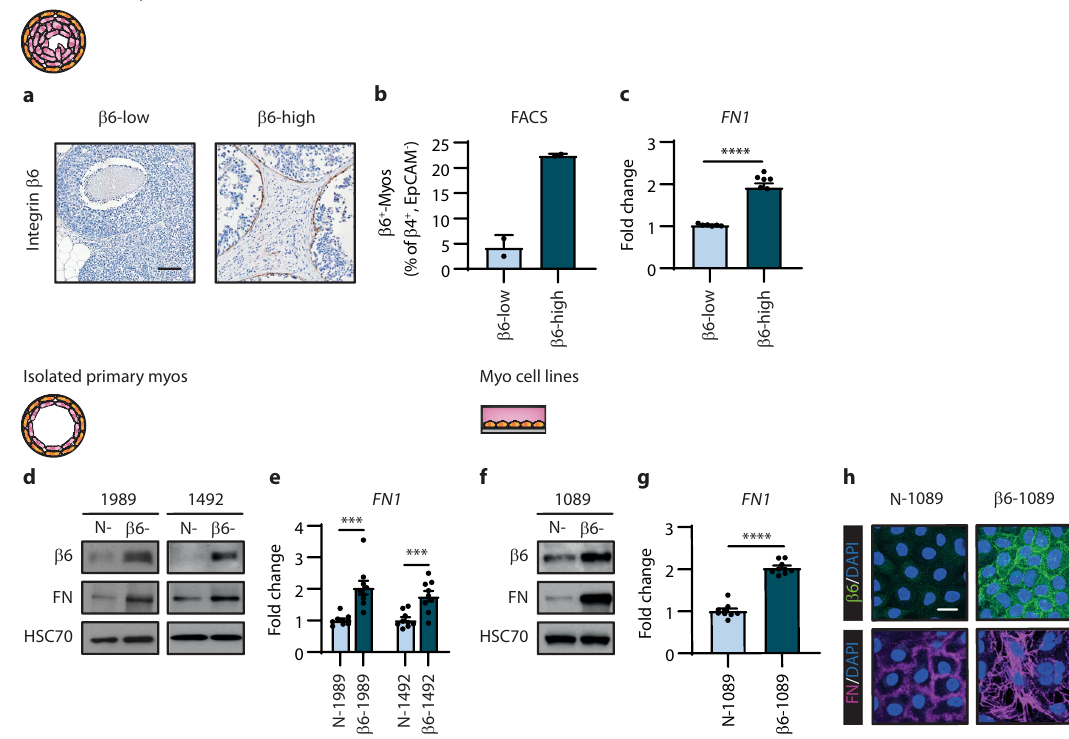
Fig. 2 Integrin β 6-positive myoepithelial cells upregulate fi bronectin expression. a Representative images of integrin β 6 by immunohistochemical staining in human DCIS tissue samples classi fi ed as low and high expression of integrin β 6. Scale bar, 100 μ m. b Bar graph showing the percent integrin β 6-positive ( β 6 + ) myoepithelial (myo) cells ( β 4 + EpCAM - ) in human DCIS samples ( n = 4) (error bars, + s.e.m). c Bar graphs showing qRT-PCR analysis for FN1 using RNA isolated from DCIS myoepithelial cells with integrin β 6-low ( n = 2) and β 6- high ( n = 2) expression (error bars, + s.e.m). 3 technical replicates; **** P < 0.0001 (two-tailed t -test). d Immunoblots of integrin β 6 and fi bronectin (FN) in primary normal myoepithelial cells; 1989 and 1492, transfected with an empty vector (N-) or integrin β 6 expression construct ( β 6-). HSC70 serves as loading control. Images are representative of three experiments. e Bar graphs showing qRT-PCR analysis for FN1 using RNA isolated from primary normal myoepithelial cells, generated as in ( d ) (error bars, + s.e.m). n = 3 biological replicates, 3 technical replicates; 1989 *** P = 0.0003 and *** P = 0.0009 (two-tailed t -test). f Immunoblots of integrin β 6 and fi bronectin in myoepithelial cell lines; N-1089 and β 6-1089. HSC70 serves as loading control. Images are representative of three experiments. g Bar graphs showing qRT-PCR analysis for FN1 using RNA isolated from myoepithelial cell lines as in ( f ). n = 3 biological replicates, 3 technical replicates; **** P < 0.0001 (two-tailed t - test). h Representative images of integrin β 6 (green) and fi bronectin (FN, magenta) by immuno fl uorescent staining in myoepithelial cell lines as in ( f ). Nuclei were counterstained with DAPI (blue). Scale bar, 20 μ m. Images are representative of three